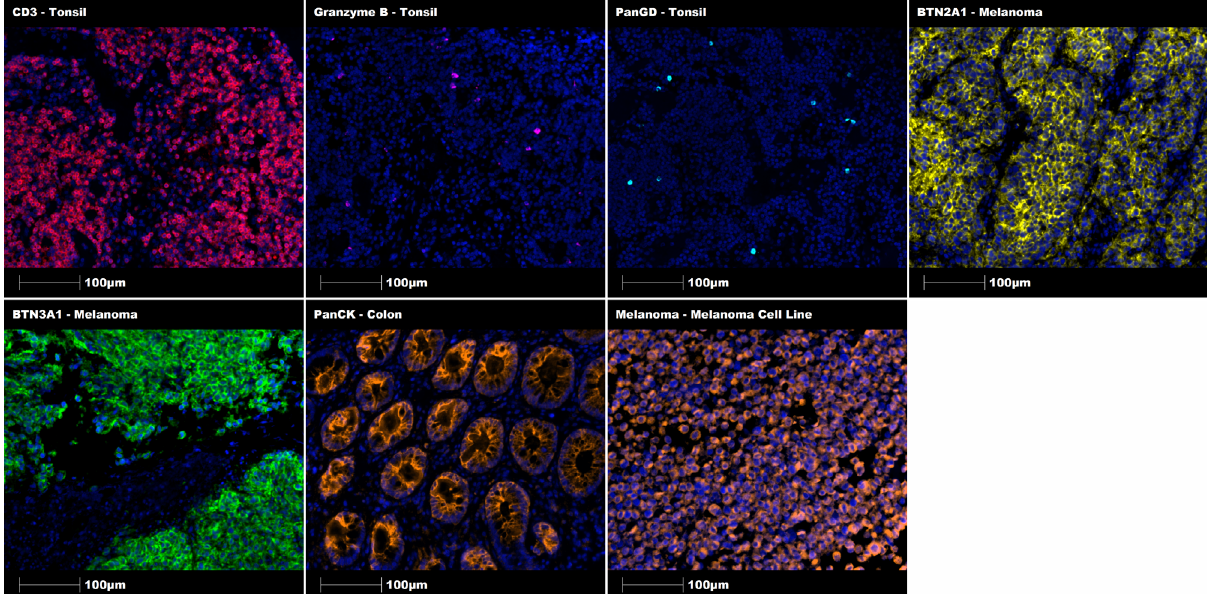
Figure 2. Positive control staining of individual markers using specific tissue sections. Representative regions of interest showing CD3 in tonsil (red), granzyme B in tonsil (magenta), Pan-γδ in tonsil (cyan), BTN2A1 in melanoma (yellow), BTN3A1 in melanoma (green), PanCK in colon (orange), melanoma cocktail in melanoma (orange) with DAPI (blue) counterstain. All images were taken at 20× magnification, and scale bars indicate 100 µm